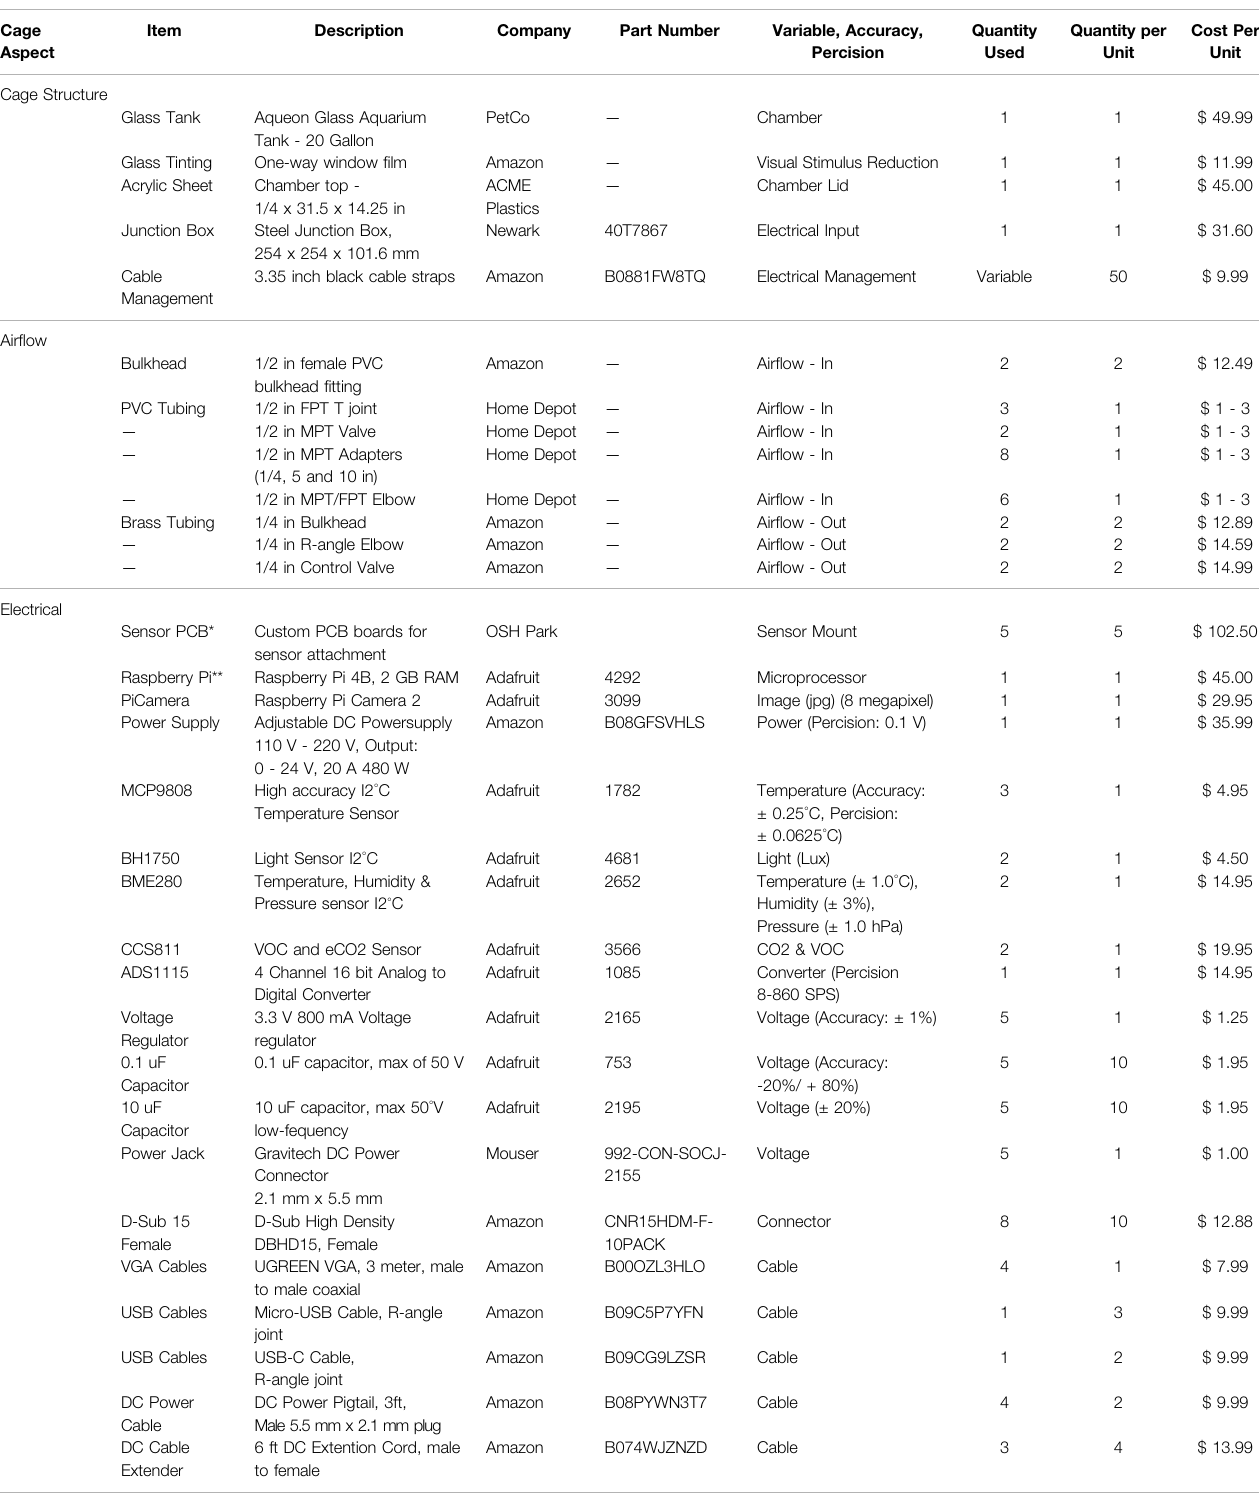
TABLE 1 | Major components and prices included in the chamber creation as of June